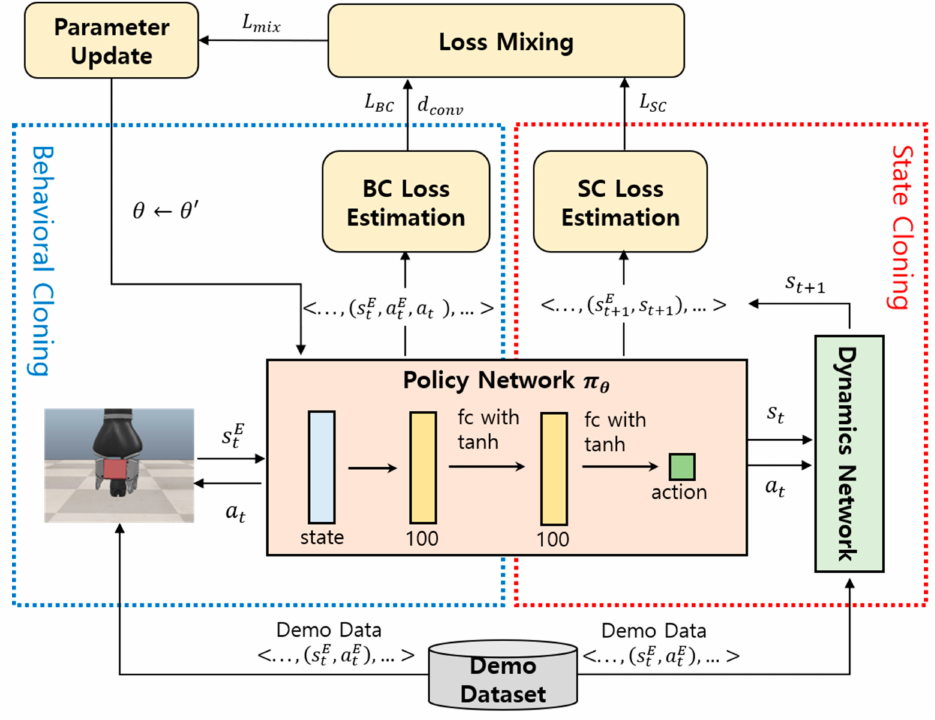
Figure 3. Hybrid imitation learning (HIL)